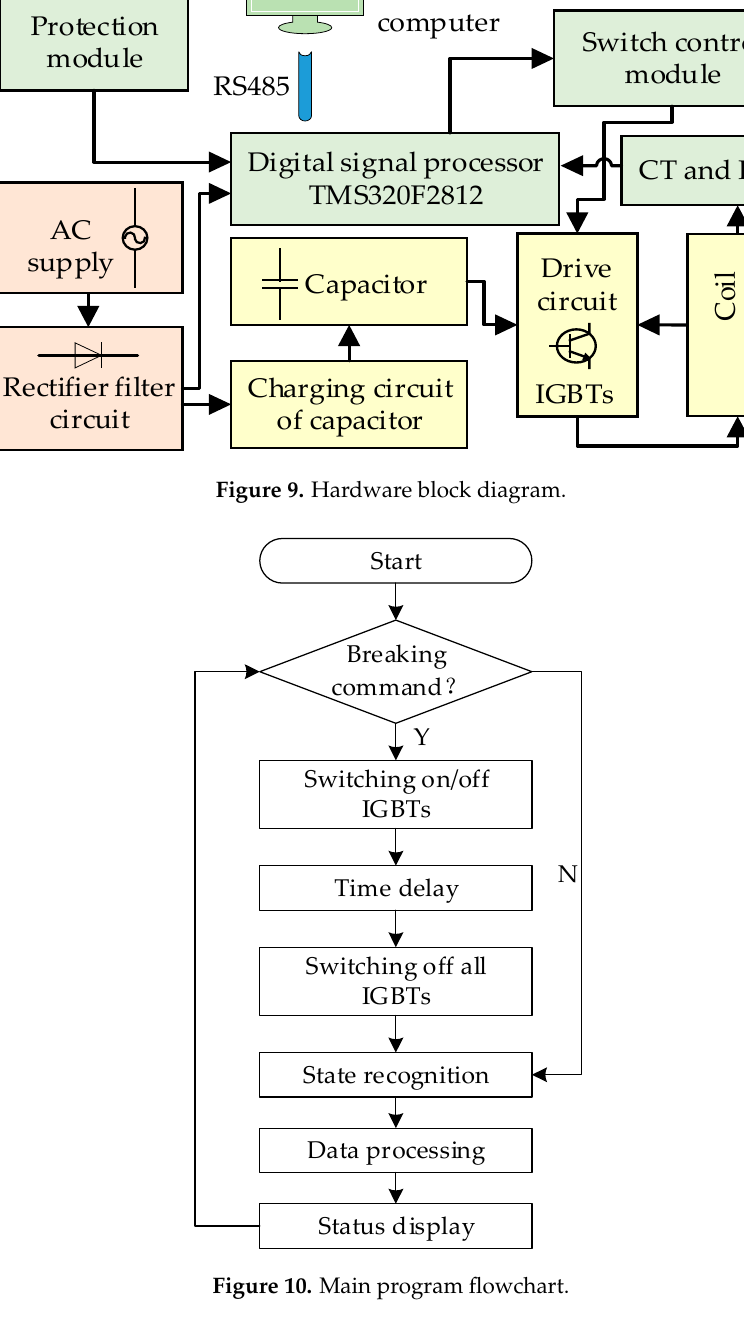
Figure 10. Main program flowchart.